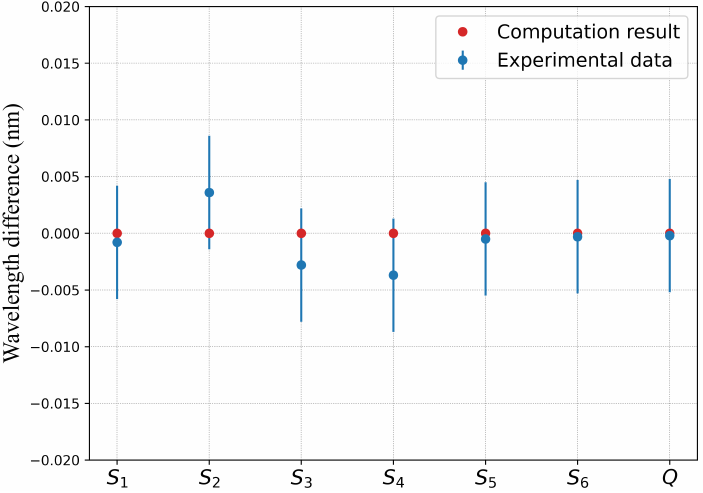
Figure 5. Bragg wavelength difference between the experimental data and the computations corre- sponding to the control points for FBG #1 with